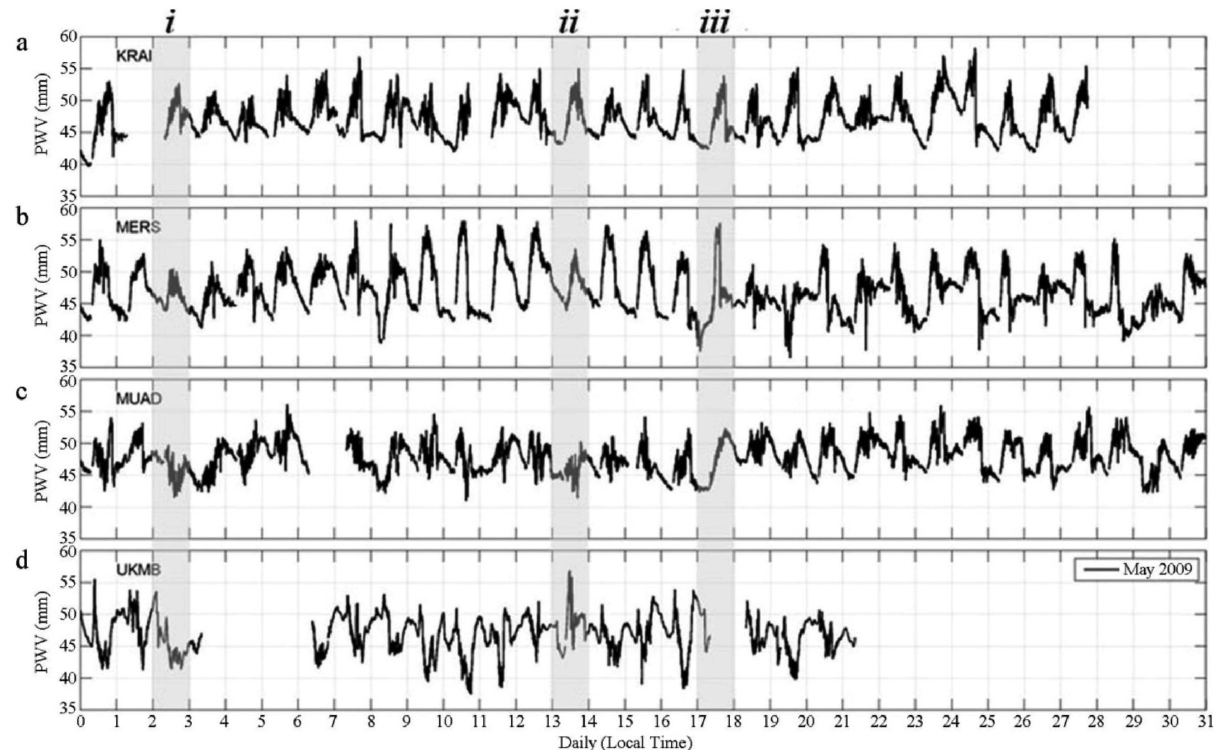
Figure 7. GPS PWV variation during the first inter-monsoon at four selected